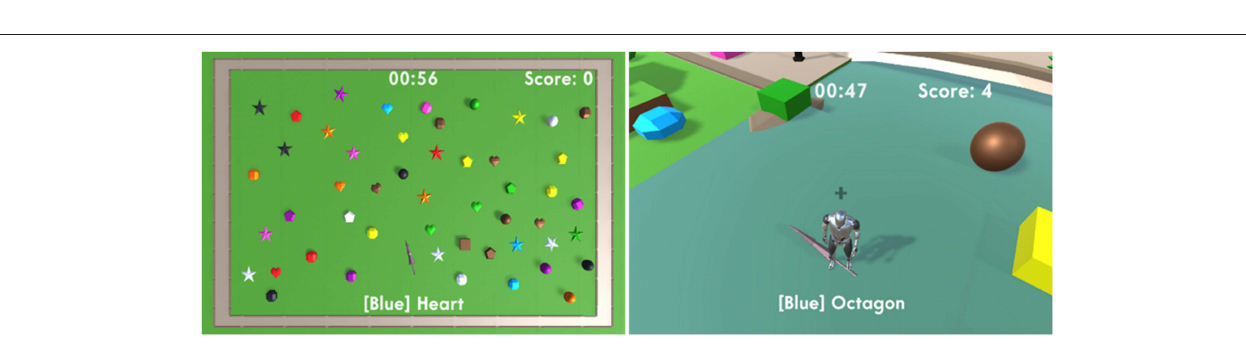
FIGURE 5 | The Compass technique. An arrow above appears above the target shape to find, directing the player toward the